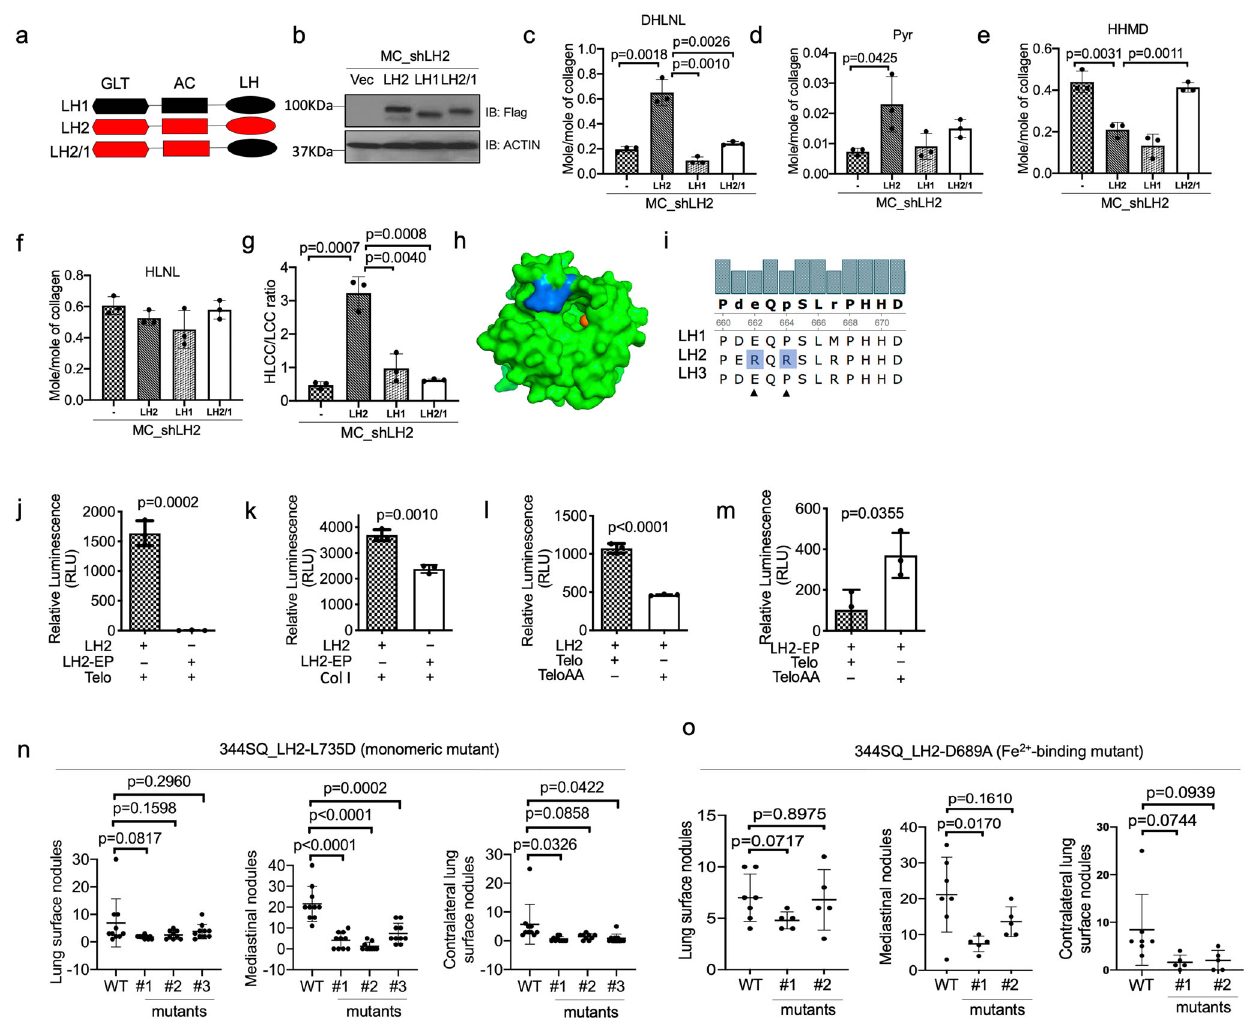
Fig. 2 LH2 t-LH speci fi city is determined by electrostatic interactions with collagens. a Design of LH constructs. Glycosyltransferase (GLT), accessory (AC), and lysyl hydroxylase (LH) domains. LH2 ’ s LH domain replaced with that of LH1 (LH2/1). b LH2 protein levels were determined by western blot analysis of MC-3T3 (MC) cells that were stably co-transfected with LH2 shRNA (shLH2) and empty vector (-) or vectors expressing LH2, LH1, or LH2/1. Actin used as loading control. c – g Collagen cross-link quanti fi cation of matrices derived from MC-3T3 (MC) cells described in ( b ). Dihydroxylysinonorleucine (DHLNL, c ), pyridinoline (Pyr, d ), histidinohydroxymerodesmosine (HHMD, e ), hydroxylysinonorleucine (HLNL, f ), and the HLCC-to-LCC ratio ( g ). The HLCC-to-LCC ratio was calculated as (DHLNL + Pyr)/HHMD. h LH2b LH domain structure was modeled using a homology-modelling server SWISS-MODEL. The structure model identi fi es a cluster of arginine residues (marine) near the LH2 active site. Fe 2 + molecule (orange ball) in active site. i Amino acid sequence alignment of human LHs. R680 and R682 in LH2 (arrow heads) are not in LH1 and LH3. j – m LH activity of LH2 and LH2-EP on a trimeric telopeptide ( j , l , m ) or type I collagen ( k ). Acidic residues at i-1 and i-2 positions in telopeptide (Telo) were mutated to alanine (TeloAA). LH activity was measured by detecting succinate production with (middle plot) or contralateral lung (right plot). Mice were injected intra-thoracically with parental (WT) or CRISPR/Cas-9-edited 344SQ cells. Plod2